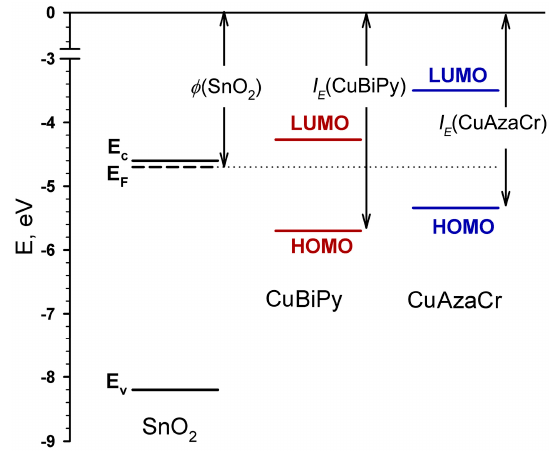
Figure 7. A diagram reflecting the relative positions of the energy levels for bulk SnO 2 and CuBiPy and CuAzaCr complexes: conduction band E c , valence band E v , Fermi level E F , work function ϕ , ionization energy I E .